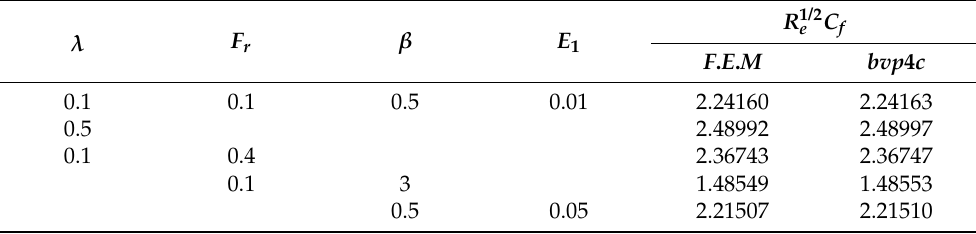
Figure 11. ( a ) Surface plot for velocity, ( b ) streamlines ( c ) surface plot for temperature, ( d ) isothermal Figure 11. (𝐚) Surface plot for velocity, (𝐛) sStreamlines (𝐜) surface plot for temperature, (𝐝) contours using software with U w = 0.5, k ( T ) = 90 ( 1 + 30 T ) , β = 0.7, E 1 = 100, M = 0.5, E c = 0.7. isothermal contours using software with 𝑈 (cid:3050) = 0.5, 𝑘(𝑇) = 90(1 + 30𝑇), 𝛽 = 0.7, 𝐸 (cid:2869) = 100, 𝑀 = 0.5, 𝐸 = 0.7 . (cid:3030) Table 3. List of numerical values for the skin friction coefficient (excluding the Reynolds number) using M =